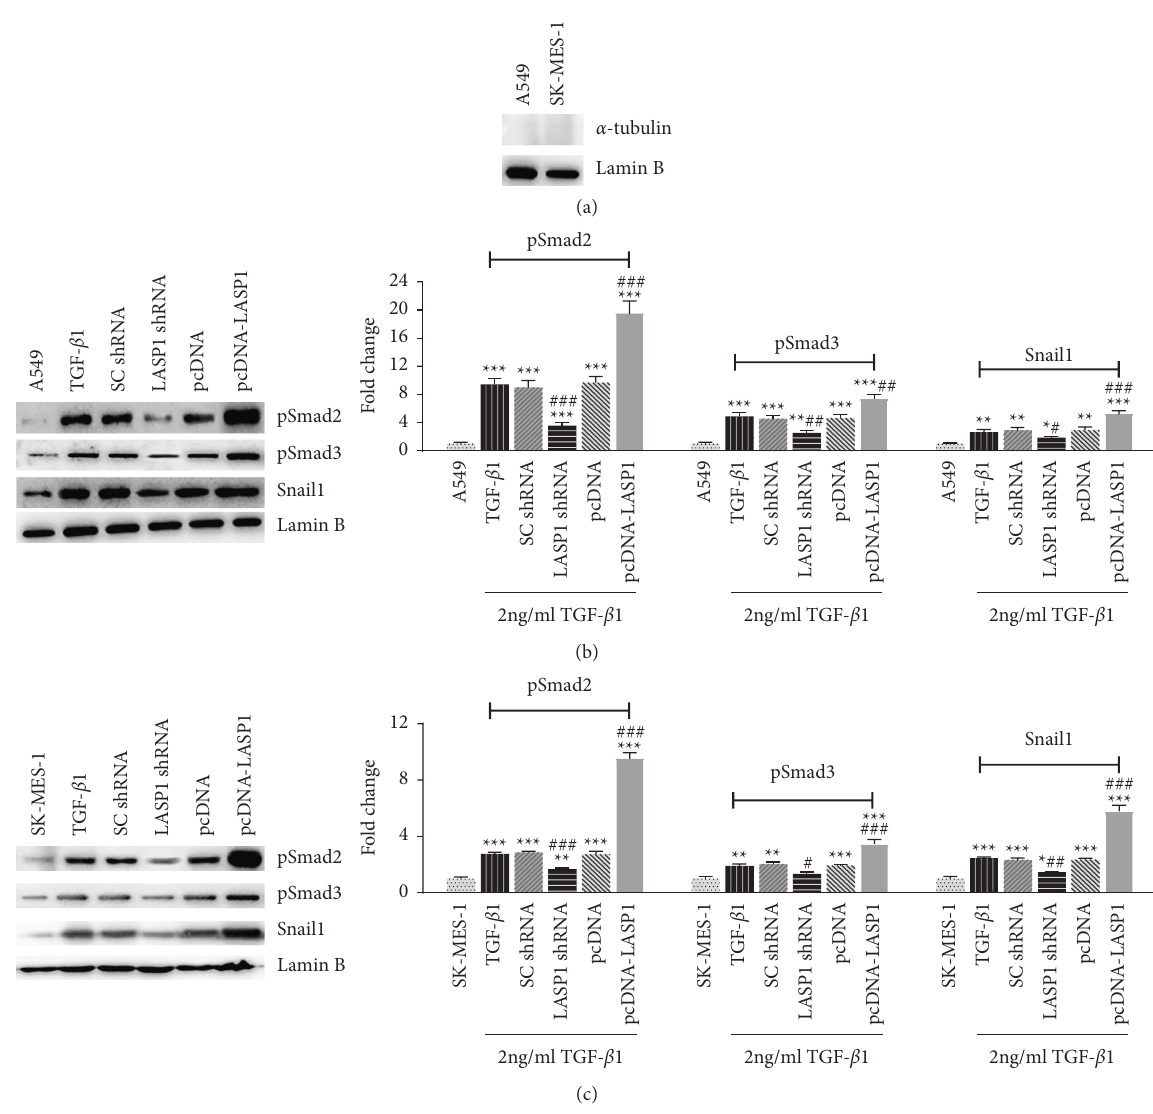
Figure 6: (a–c) LASP1 effect on nuclear levels of key molecules in the TGF- β 1/Smad/Snail signaling pathway in A549 and SK-MES-1 cell lines under TGF- β 1 treatment. After 48h coinfection with TGF- β 1 accompanying LASP1 knockdown or overexpression, the nuclear fractions were detected for protein levels of pSmad2, pSmad3, and Snail1 by western blot. (a) α -Tubulin (cytoplasmic marker) and Lamin B (nuclear marker) demonstrated the purified nuclear extracts. The representative images of western blot and the quantification normalized with (b) Lamin B in A549 and (c) SK-MES-1 cells. Data were shown as mean ± SD, n � 3. ∗∗ p < 0 . 01 and ∗∗∗ p < 0 . 001 vs . the cell alone group without TGF- β 1 treatment, and # p < 0 . 05, ## p < 0 . 01, and ### p < 0 . 001 vs. the TGF- β 1-treated noninfection group (TGF- β